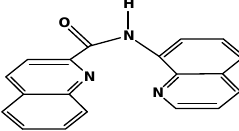
Figure 1. The QCA